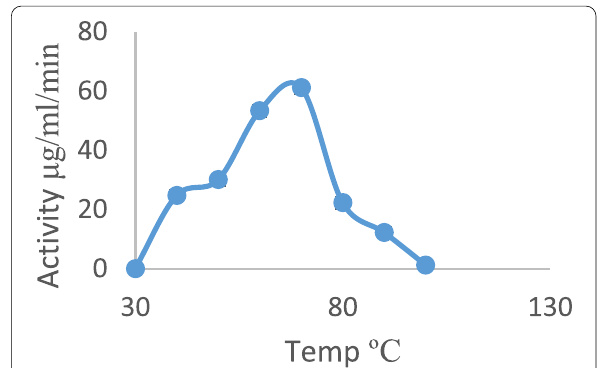
Fig. 3 Effect of temperature on amylase obtained from the submerged fermentation of P. tuberregium